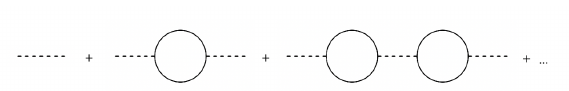
Figure 1: The induced propagator of the σ field. The dashed line stands for the σ propagator at tree level. The solid line stands for the exact propagator of b N → ∞